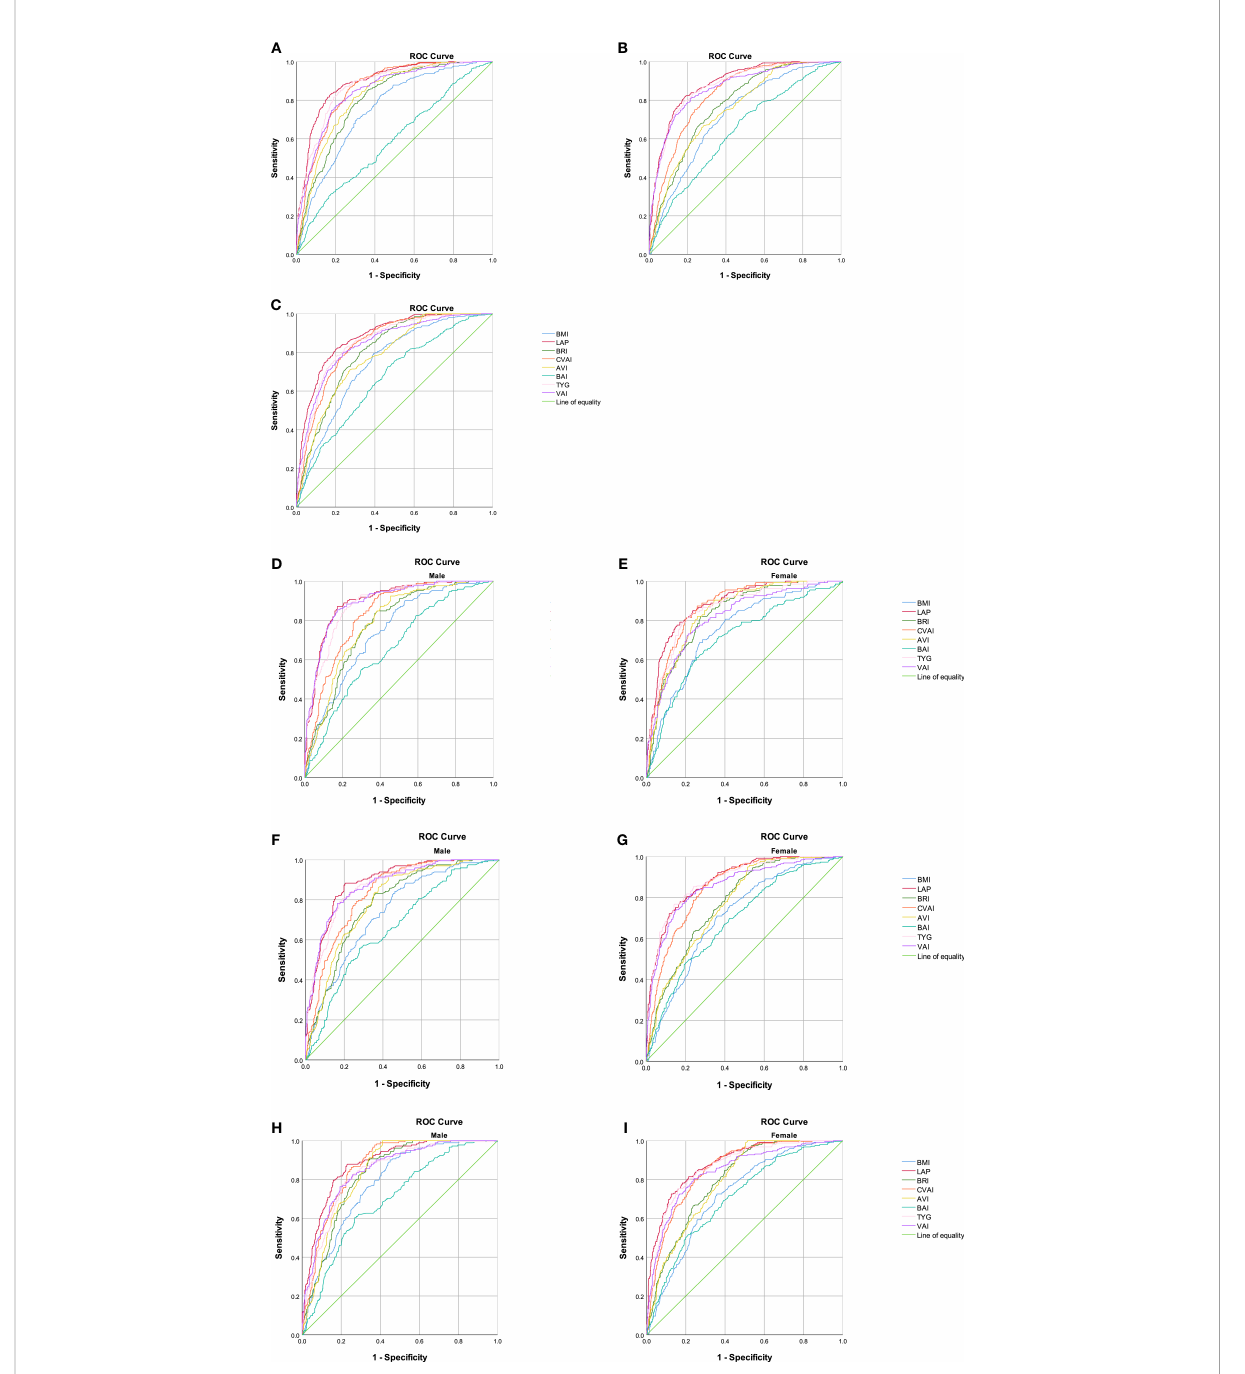
FIGURE 1 Comparison of the diagnostic values of BMI, LAP, BRI, CVAI, BAI, AVI, TYG, and VAI in predicting metabolic syndrome using three criteria in a relatively healthy Chinese population. (A) Chinese (2020 edition) criteria; (B) NCEP-ATPIII criteria; (C) IDF criteria. Chinese (2020) criteria: (D) obesity- and lipid-related indices for a relatively healthy Chinese population, men; (E) obesity- and lipid-related indices for a relatively healthy Chinese population, women. NCEP-ATPIII criteria: (F) obesity- and lipid-related indices for a relatively healthy Chinese population, men; (G) obesity- and lipid-related indices for a relatively healthy Chinese population, women. IDF criteria: (H) obesity- and lipid-related indices for a relatively healthy Chinese population, men; (I) obesity- and lipid-related indices for a relatively healthy Chinese population,